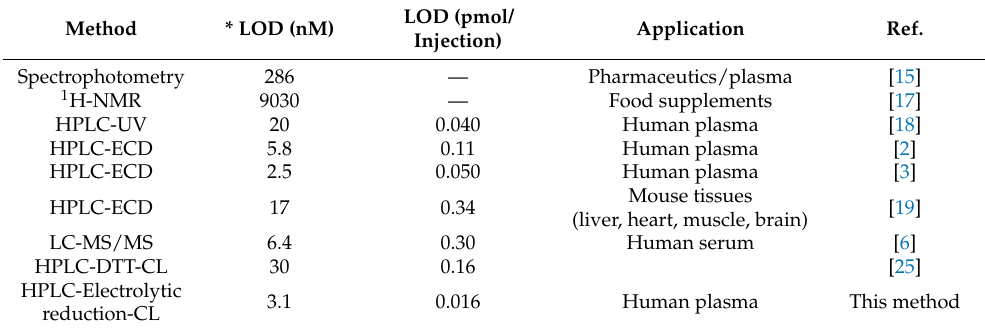
Table 5. The comparison of the sensitivity of the proposed methods with the previously reported methods in the